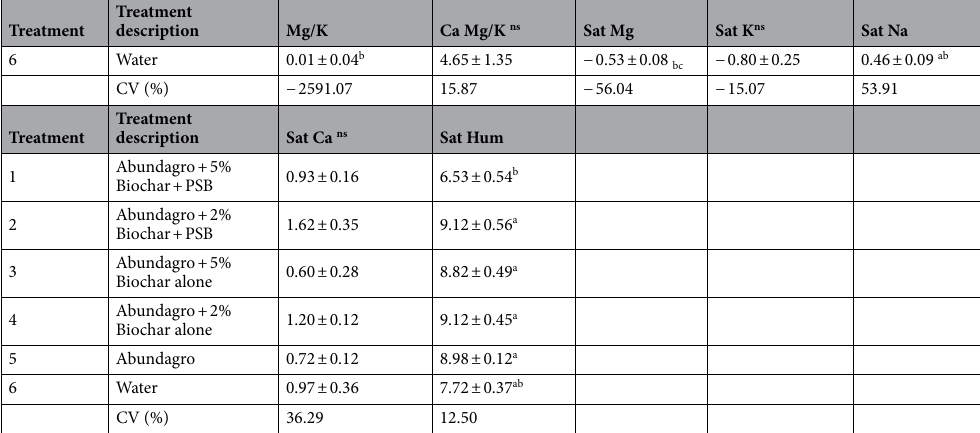
Table 5. Variation of physical and chemical characteristics of soil used (initial-final values) before and after A. cepa L. cultivation in pots. Letters show heterogeneous groups based in Tukey’s test and indicate significant differences among treatments ( p < 0.05). ns = no significant differences ( p > 0.05). CV = coefficient of